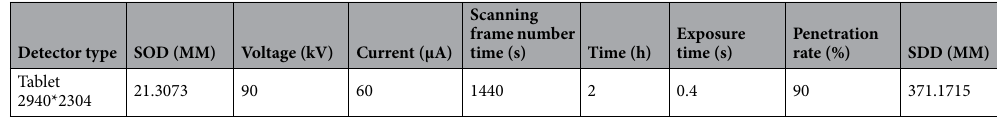
Table 2. Scanning parameters of X-ray 3D